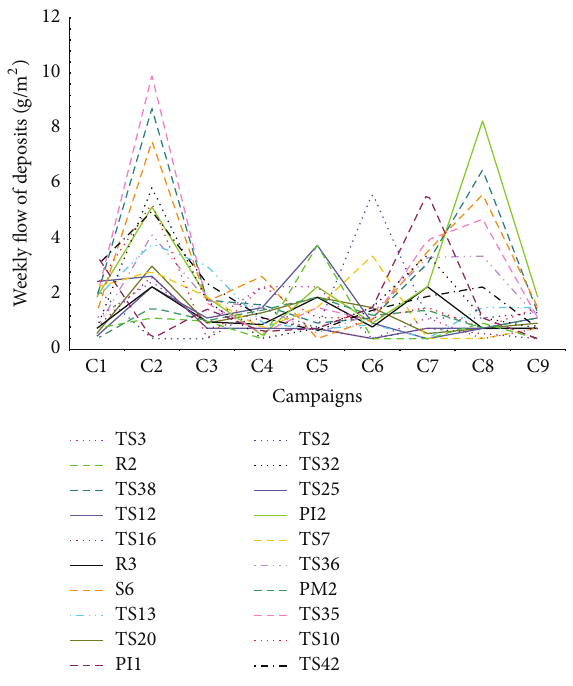
Figure 8: Temporal variation of deposits particles fluxes above the solar